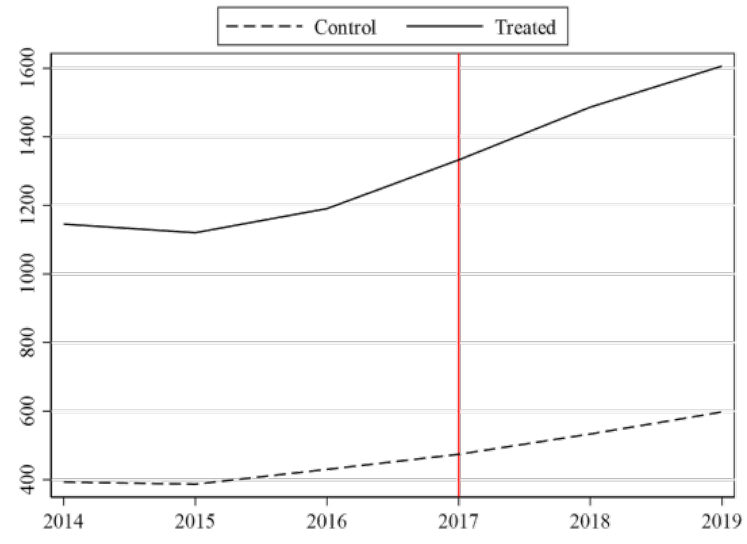
Figure 4. Synthetic difference-in-differences fitting.